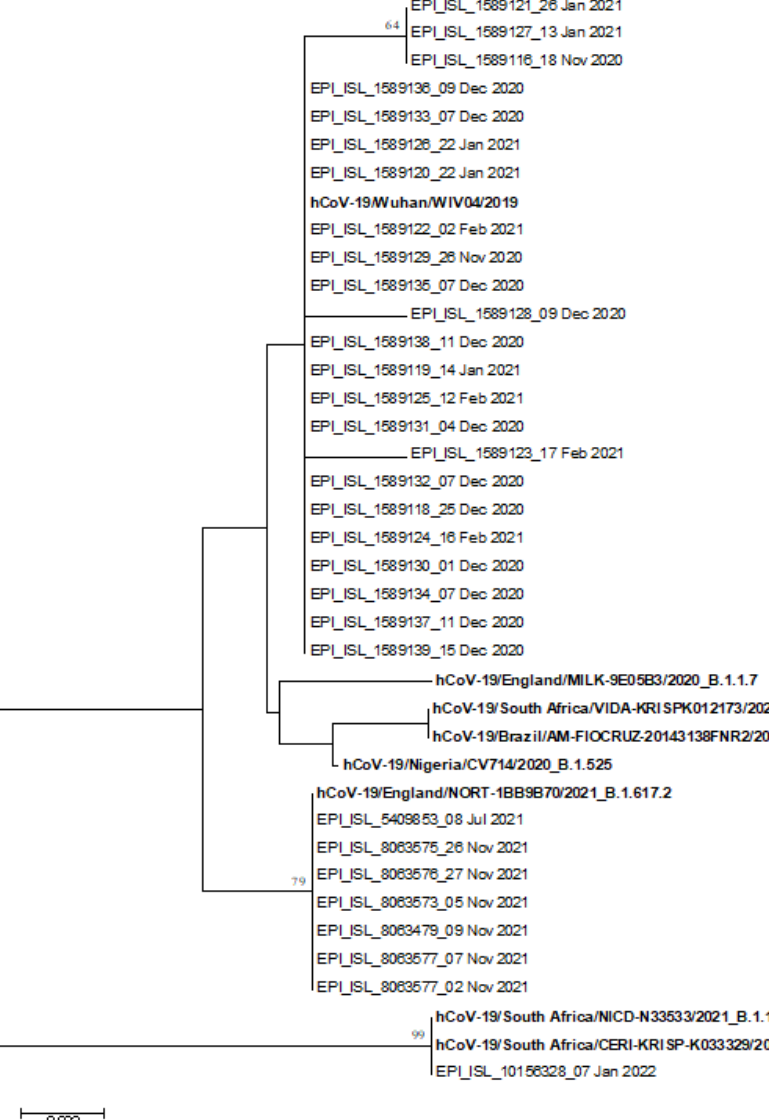
Figure 1. Phylogenetic tree of the 31 S gene nucleotide sequences of study SARS ‐ CoV ‐ 2 strains identified in Trieste and reference strains (in bold).